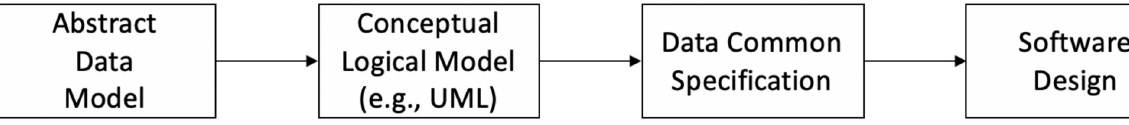
Fig 6. Sequence of data models for reasoning about experiments and modeling and simulation. We advocate for pre-pending the abstract data model to the front end of the model process, as shown here. Table 3 shows our abstract data model and Fig 7 shows this data model translated into a entity-relationship diagram in unified modeling language (UML) form. The table and figures in A (which support Section 7) show the Data Common Specification for our software design.